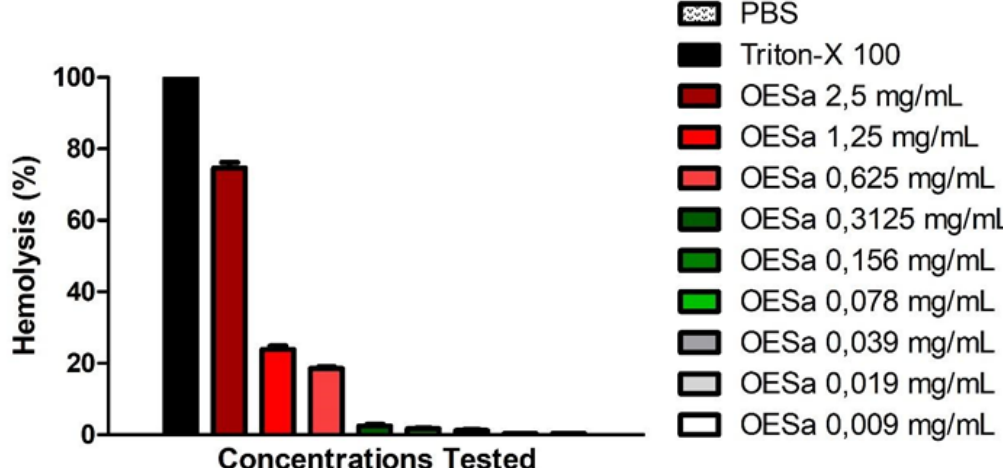
Figure 2. Hemolytic activity of S. aromaticum essential oil. Black bars indicate 100% of hemolysis; red bars indicate moderate and high hemolysis; green bars indicate low hemolysis; White bars indicate no hemolysis, p < 0.001, one-way ANOVA.